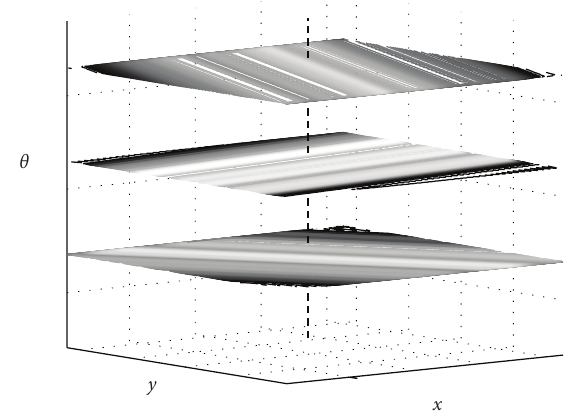
Figure 2: An illustration of a stackgram with three back-projected projections. The signals along the sinusoidal curves of the sinogram (as in Figure 1(a)) correspond to the signals through the layers of the stackgram. A signal such as this is illustrated with the dashed line in the shown stackgram; denoted as the locus signal. Notice the relation of the stackgram coordinates in comparison with the sinogram and image